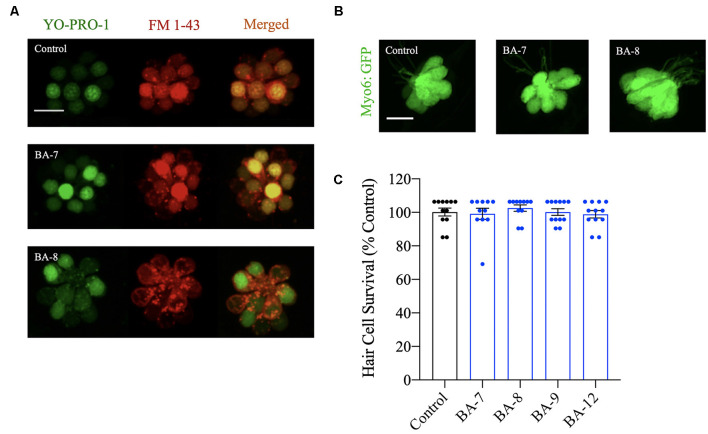
Hair cells are viable after analog exposure. (A) Zebrafish were pretreated with the nuclear marker YO-PRO-1 for 1 h followed by treatment with the optimally protective concentration of each analog for 24 h. Zebrafish were then rinsed in embryo medium (EM) and treated with FM 1–43FX to assess mechanoelectrical transduction (MET) channel function after prolonged analog exposure and removal. Analog treatment did not alter FM 1–43FX or YO-PRO-1-labeling. Scale bar = 10 μm. (B) Examples of Tg(myo6b:EGFP) neuromasts treated with the optimally protective concentration of each analog for 24 h before hair cell assessment. In each case, neuromast morphology appeared normal. Scale bar = 10 μm. (C) Zebrafish were exposed to the optimal protective concentration (OPC) of berbamine analog for 24 h before hair cell assessment with DASPEI. None of the analogs impact hair cell survival. Data are normalized to controls and analyzed by one-way ANOVA, F(4,48) = 0.6564, p = 0.6252. N = 11–12, bars are ± SEM.